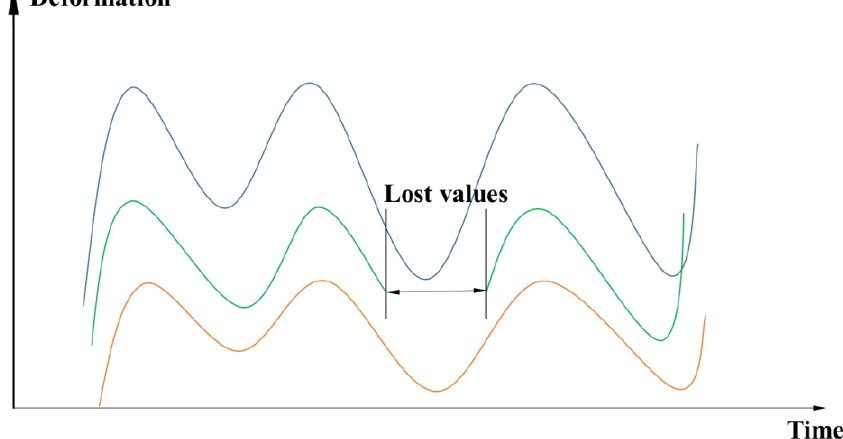
Figure 5. Partial data missing diagram.